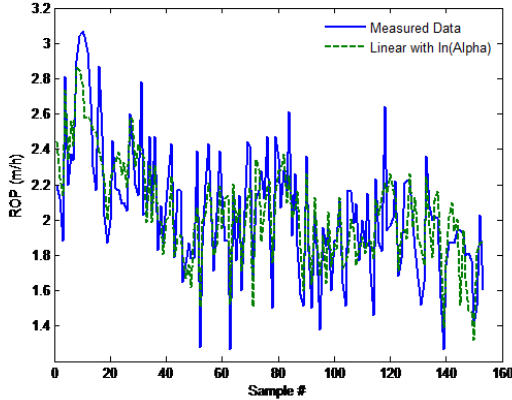
Figure 4: Linear regression model with